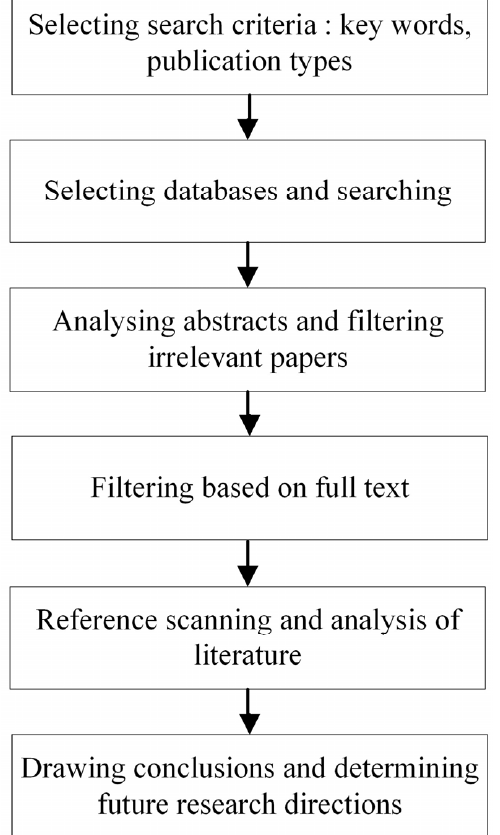
Figure 1. Flow chart of the review methodology.